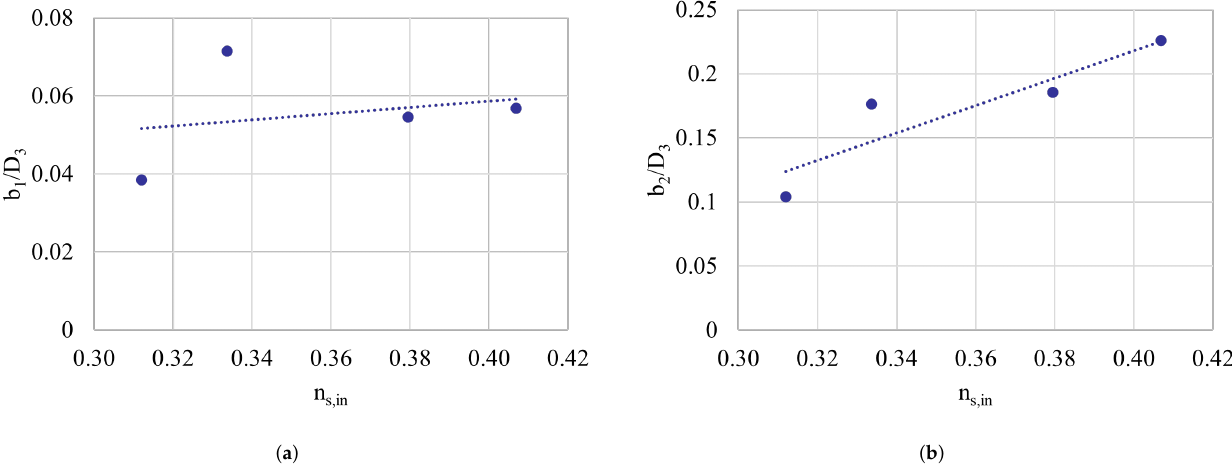
Figure 5. Example of statistical tendencies for high expansion ratio radial turbines: ( a ) inlet and ( b ) outlet channel heights. Subscripts: 1—stator inlet; 2—stator outlet; 3—rotor inlet; 4—rotor outlet.